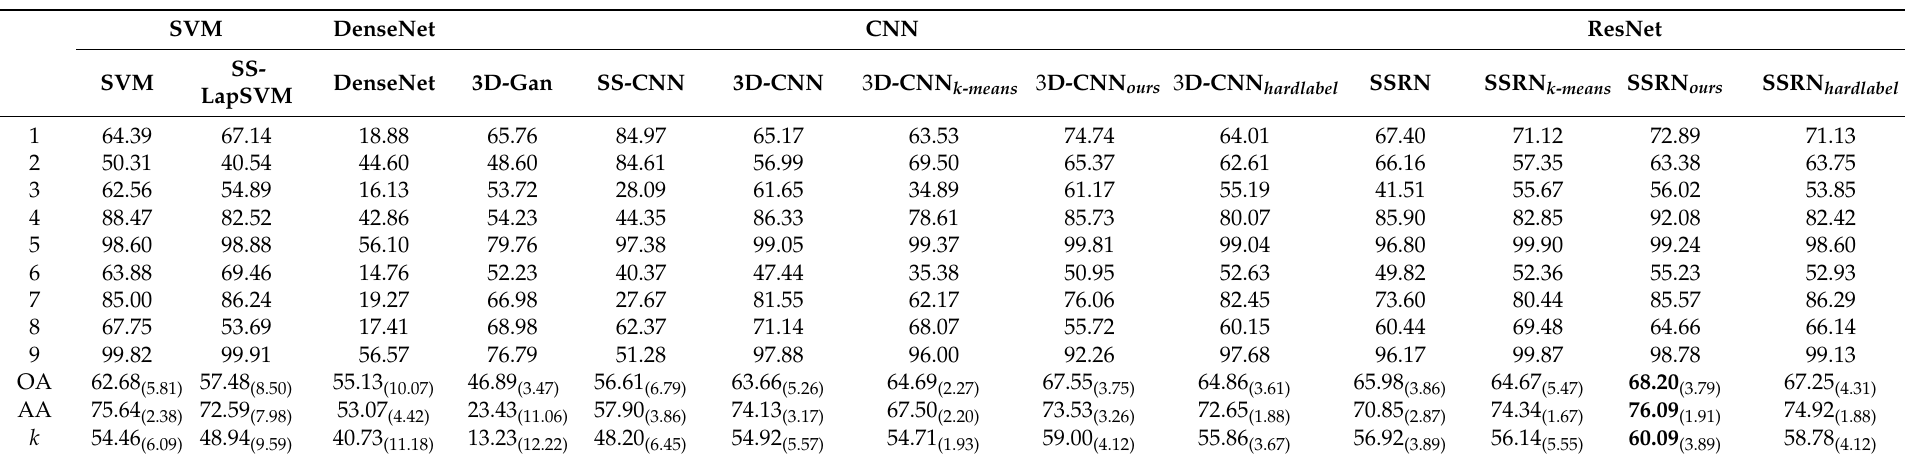
Table 3. Classification accuracy (%) for all methods with five training samples on the PaviaU